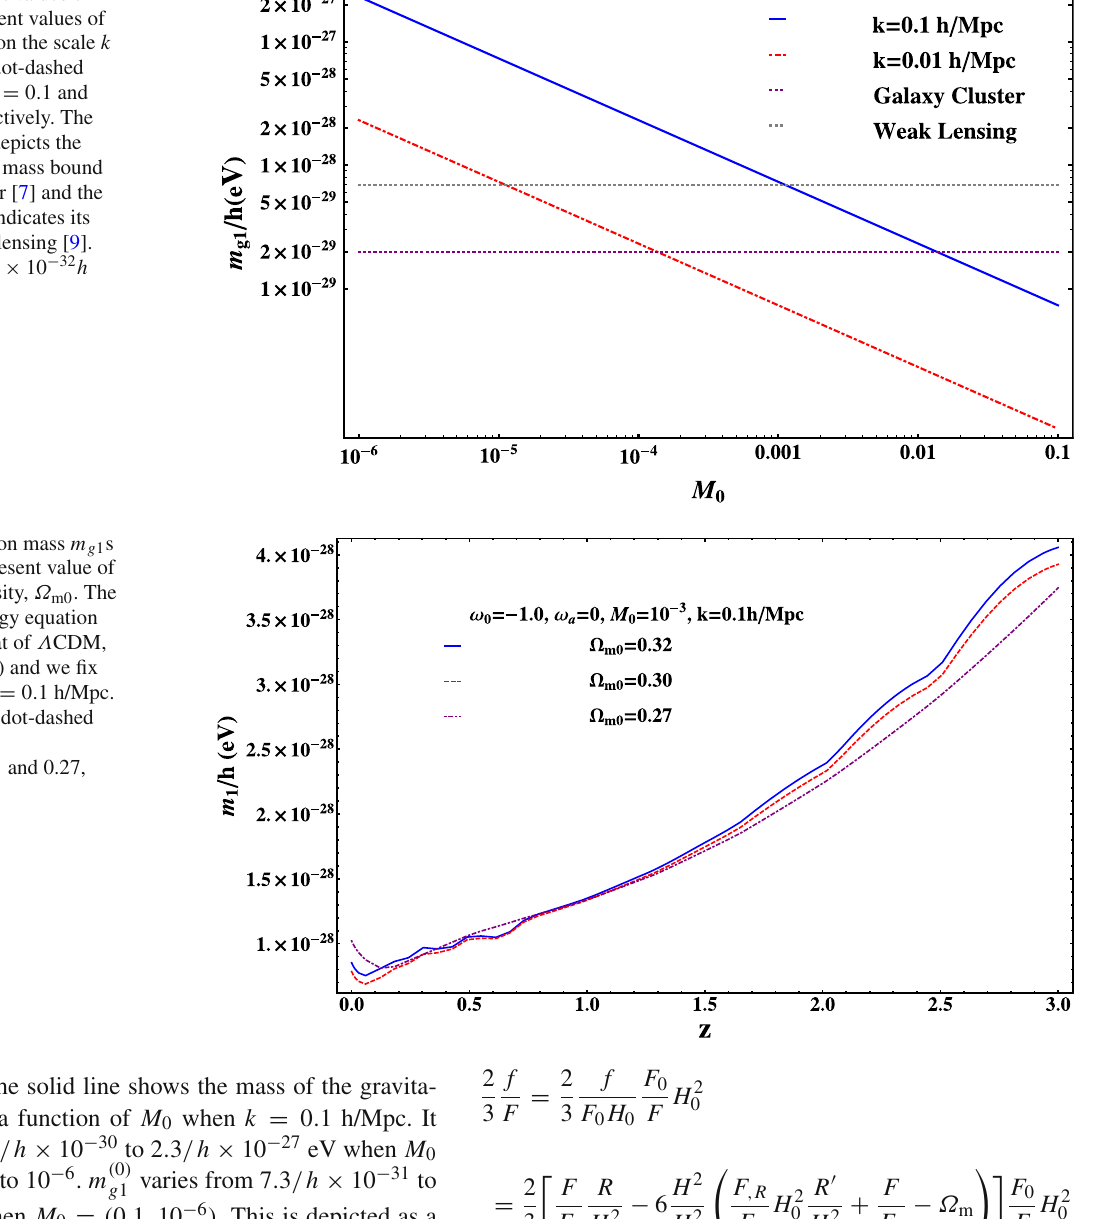
Fig. 1 The present values of m g 1 s for the different values of M 0 . They depend on the scale k and the solid and dot-dashed lines correspond k = 0 . 1 and 0.01 h/Mpc, respectively. The upper dotted line depicts the gravitational wave mass bound from galaxy cluster [7] and the lower dotted line indicates its bound from weak lensing [9].